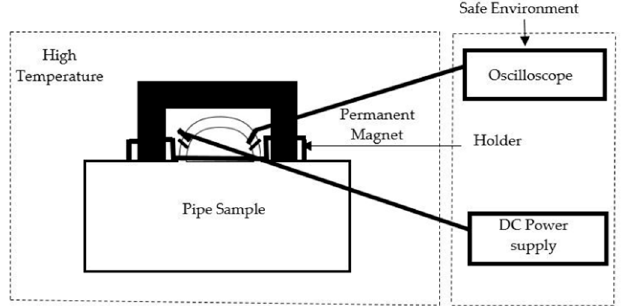
Figure 5. Schematic of experimental Set up for high temperature tests.